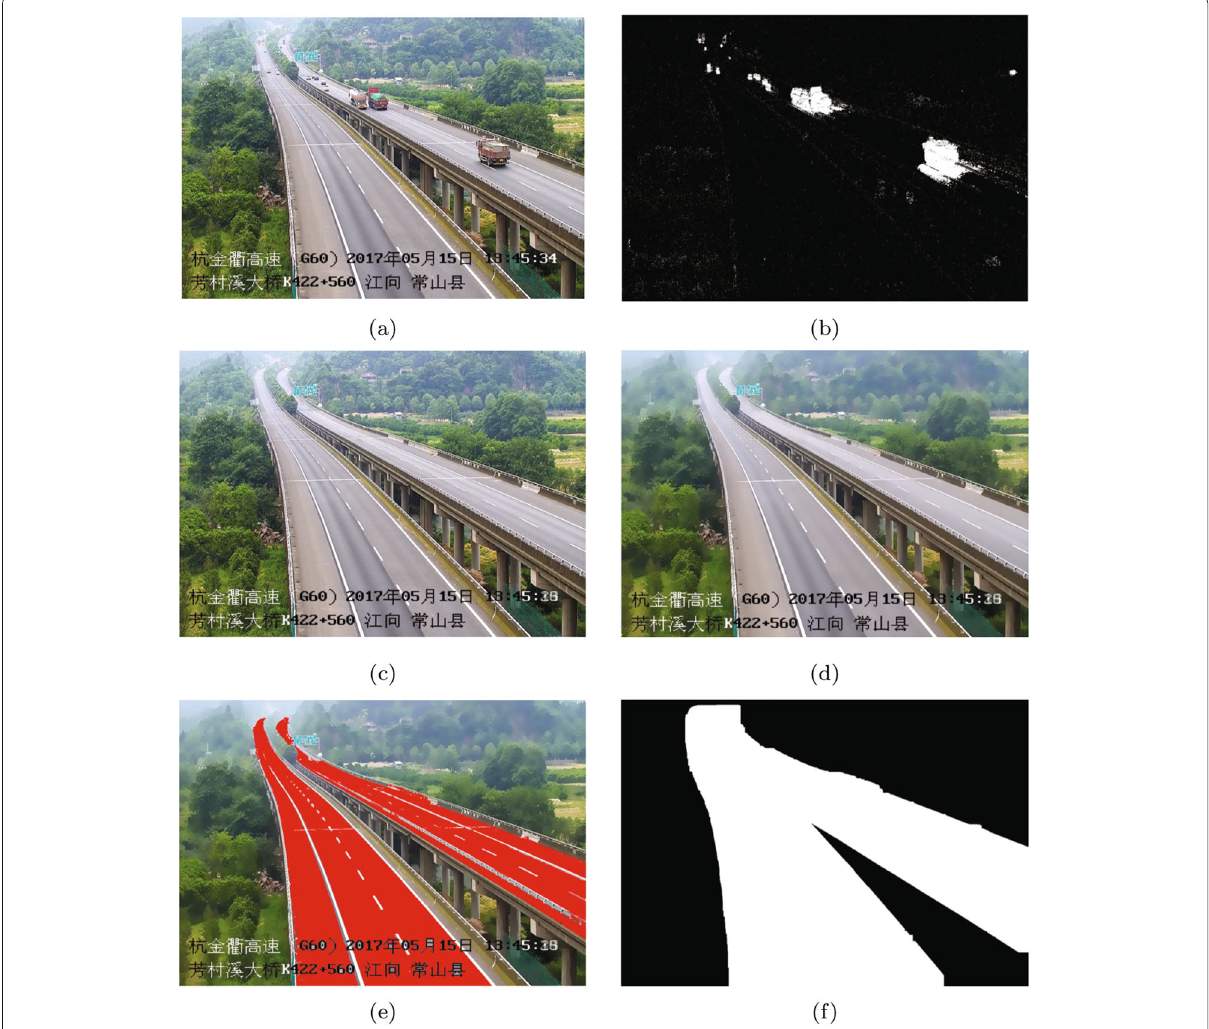
Fig. 6 Process of road surface area extraction. a Original image; b image foreground; c image background; d Gaussian filter and MeanShift filter; e diffuse filling; f road surface area